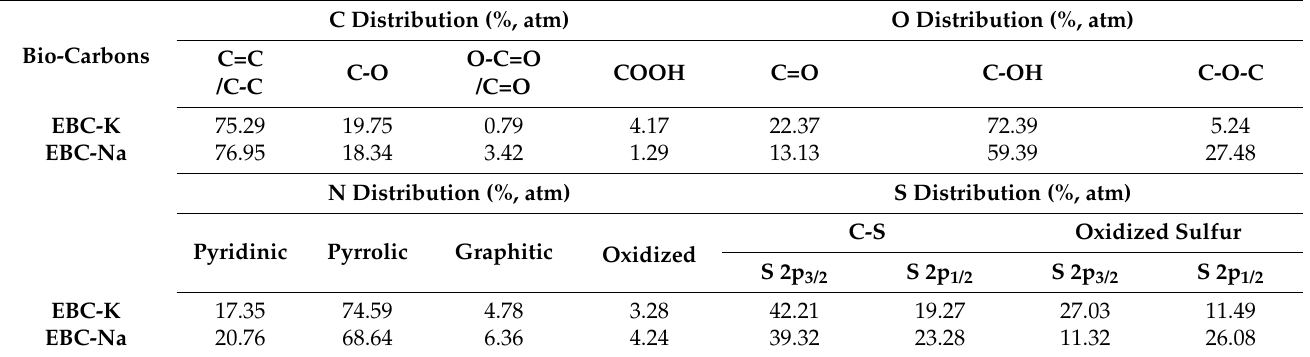
Table 1. The fitting results of the high resolution XPS spectra of C, O, N, and S for EBC-K and